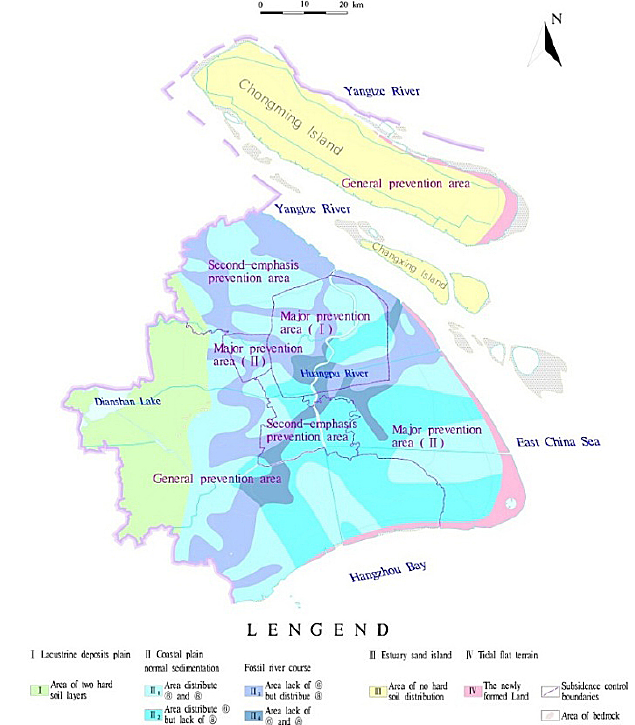
Figure 1. Geological partition for the first aquifer in Shanghai.